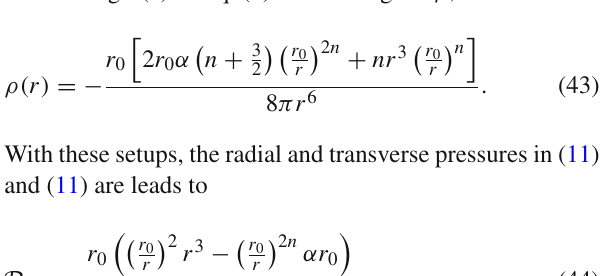
Fig. 4 The embedding diagram of wormholes geometry along the equatorial plane ( t = const, θ = π/ 2). The specific case of a con- stant redshift (cid:8) (cid:7) ( r ) = 0 with α = 0 . 1 and r 0 = 1, we have drawn embedding diagram for isotropic i.e model A and anisotropic worm- hole i.e. model B in the left and right diagram, respectively. We have considered the numerical values of ω = 0 . 5 and ω t = − 1 /